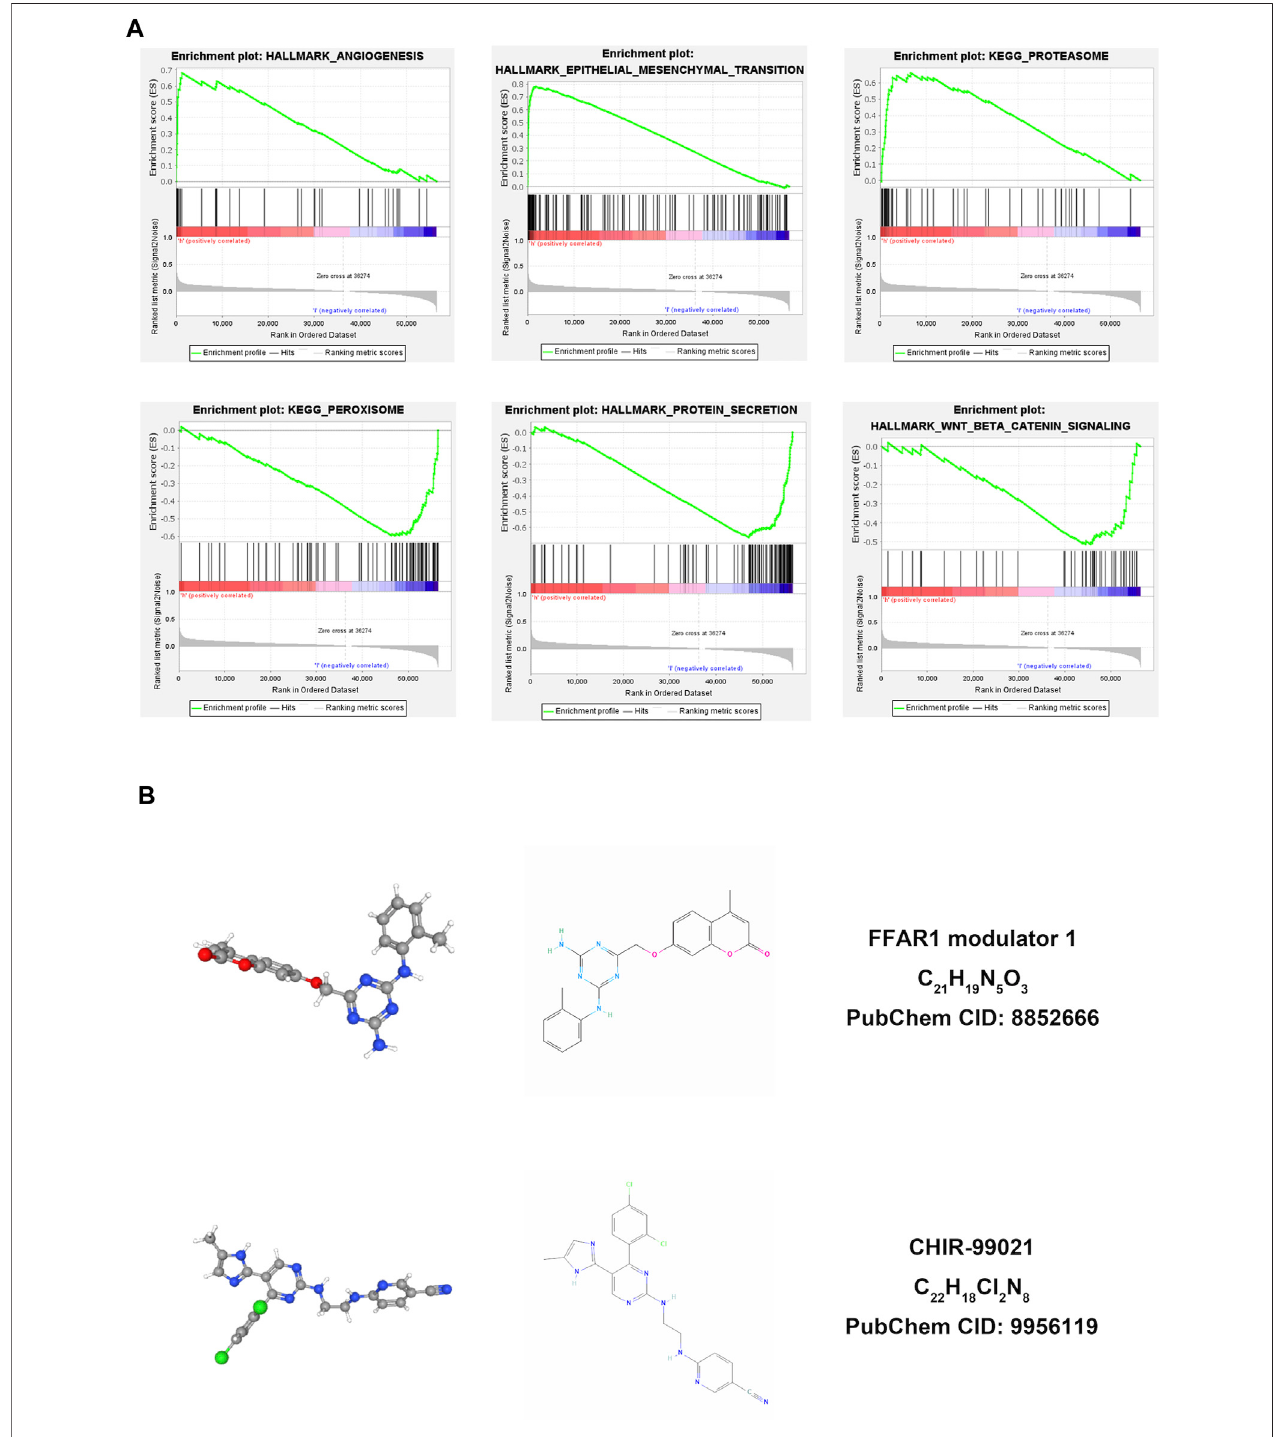
FIGURE6| TheGSEAresultswiththeexpressionofMIR4435-2HGandpredictionofsmall-molecule drugsforBRCA. (A) Thehighexpression groupofMIR4435- 2HG was primarily enriched in some signaling pathways, such as KEGG-Proteasome, KEGG-EMC RECEPTOR INTERACTION, HALLMARK EMT, HALLMARK ANGIOGENESIS,andGOBP_REGULATION_OF_EXTRACELLULAR_MATRIX_ORGANIZATION. (B) The2Dand3Dstructuresofthesetwocompoundswereidenti fi ed by the connectivity map analysis: FFAR1 modulator 1 (High) and CHIR-99021 (Low).